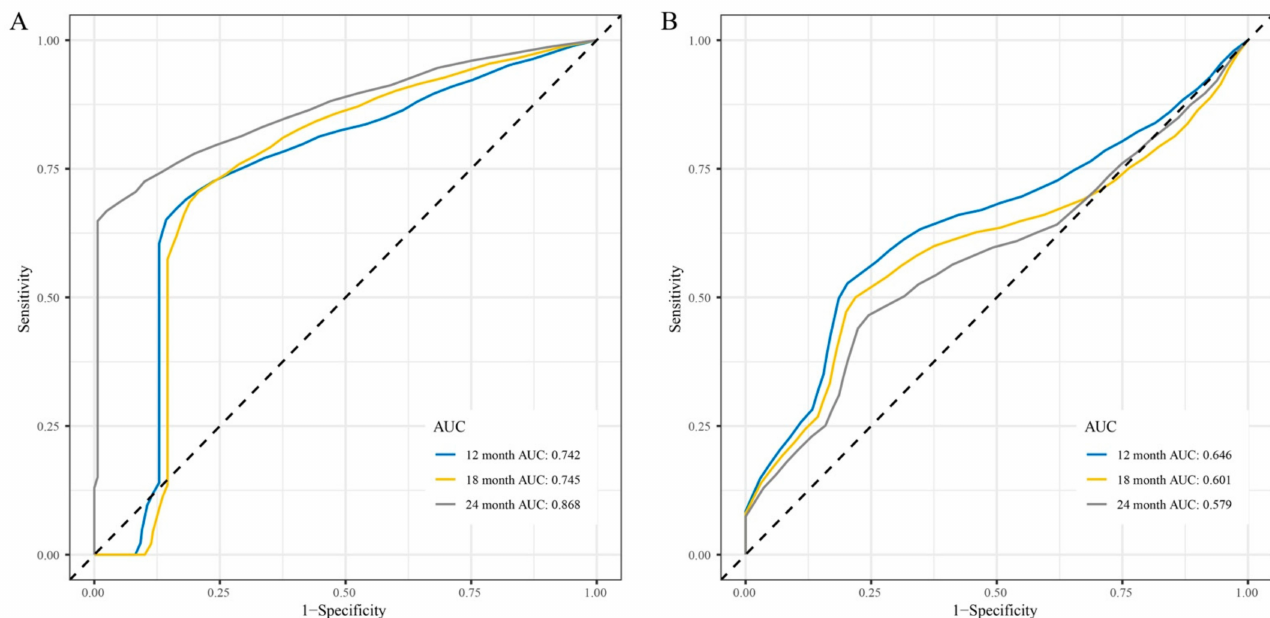
Figure 6. Time-dependent receiver operating characteristic (ROC) curves for PFS predicted with the 15 lncRNAs signature. ( A ) Time-dependent ROC curves for PFS predicted with the 15 lncRNAs signature in the training cohort. ( B ) Time-dependent ROC curves for PFS predicted with the 15 lncRNAs signature in the validation